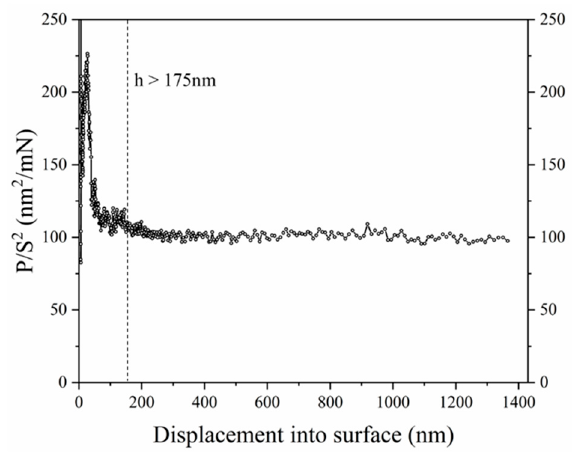
Figure 5. P / S 2 ratio versus displacement into the surface for indentations on cold rolled (CR) sample.